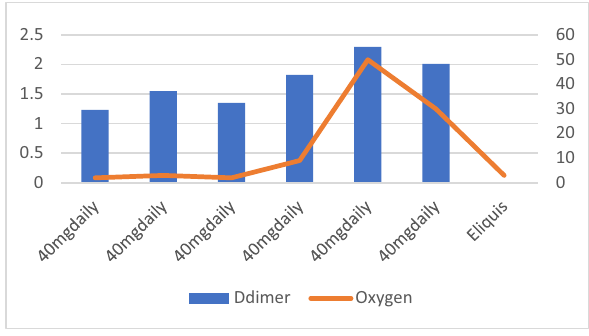
Figure 1: Patient number 1 presented at early stage requiring